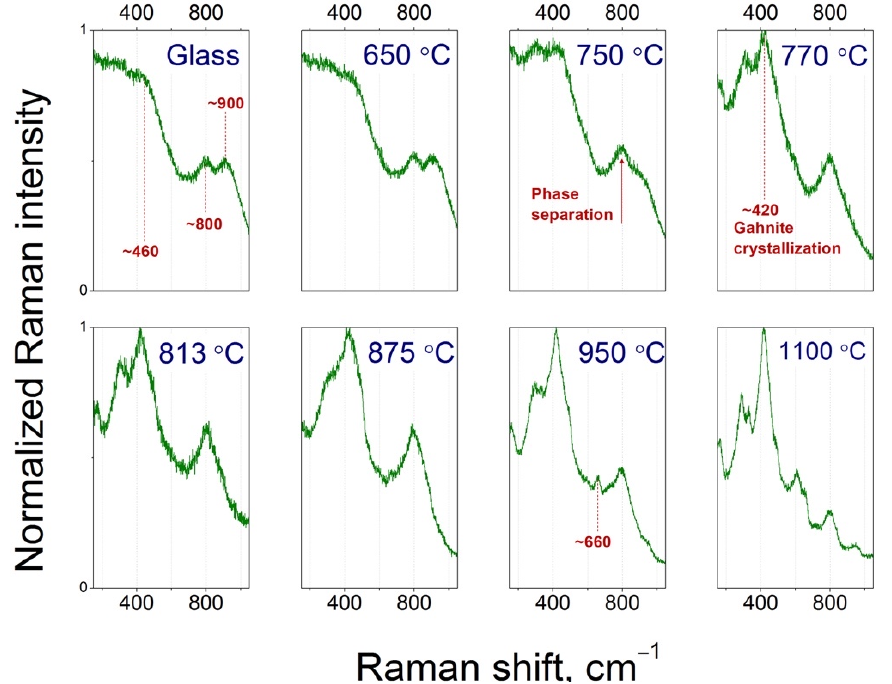
Figure 8. Raman spectra of the glass samples of the Matrix series before and after the heat treatment in the 650–1100 °C range for 20 h. in the 650–1100 ◦ C range for 20